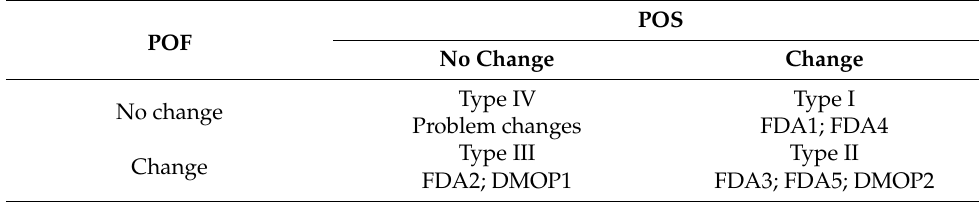
Table 2. Classification of standard benchmarks.